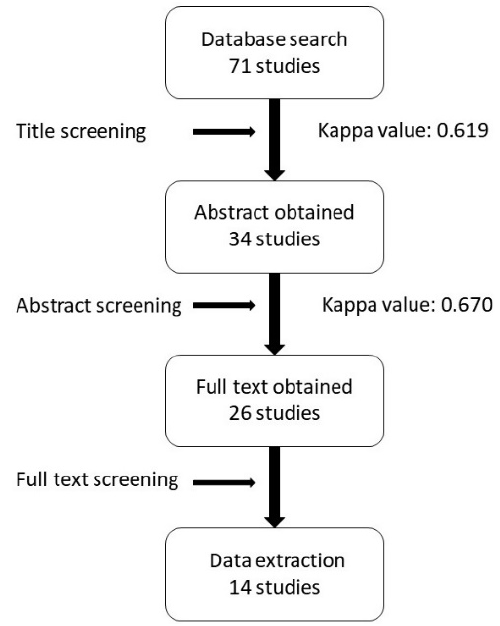
Figure 1. Flowchart of studies selected in the review.